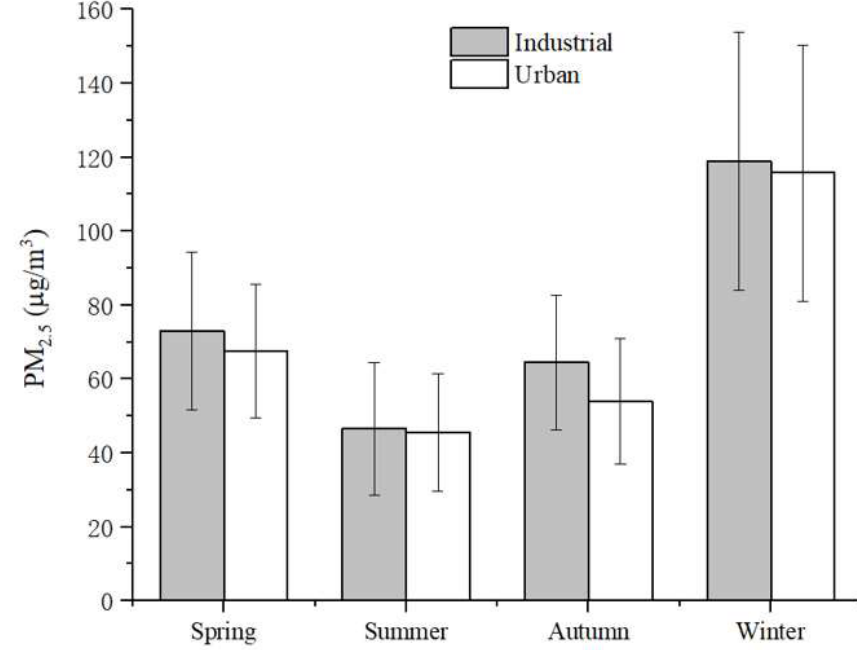
Figure 3. Seasonal average concentrations of PM 2.5 in industrial and urban areas of Nanjing city during 2016.